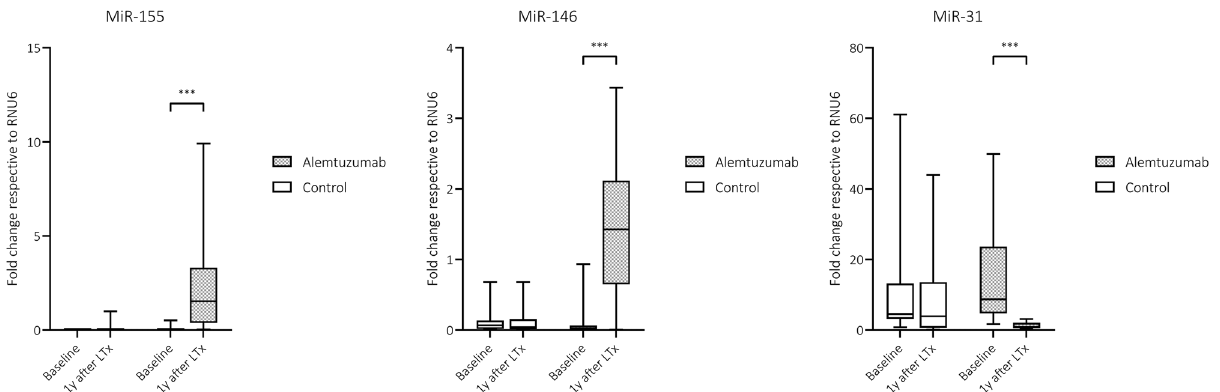
Figure 1. Expression difference of the analyzed dysregulated miRNAs at baseline and one year after induction therapy within the same groups. The Figure shows box-plots depicting miRNA expressions at the two timepoints. Both groups are represented on the graph next to each other. Mann–Whitney test was used to test the difference in expression between the two time points within the same group. In alemtuzumab group miR-155 and miR-146 are significantly upregulated compared to baseline levels. On the contrary, miR-31 is drastically downregulated. The boxes indicate interquartile range, the line across the boxes the median and the lower and upper margin of the vertical lines the minimum and maximum, respectively. * p = 0.05, ** p < 0.01, *** p <